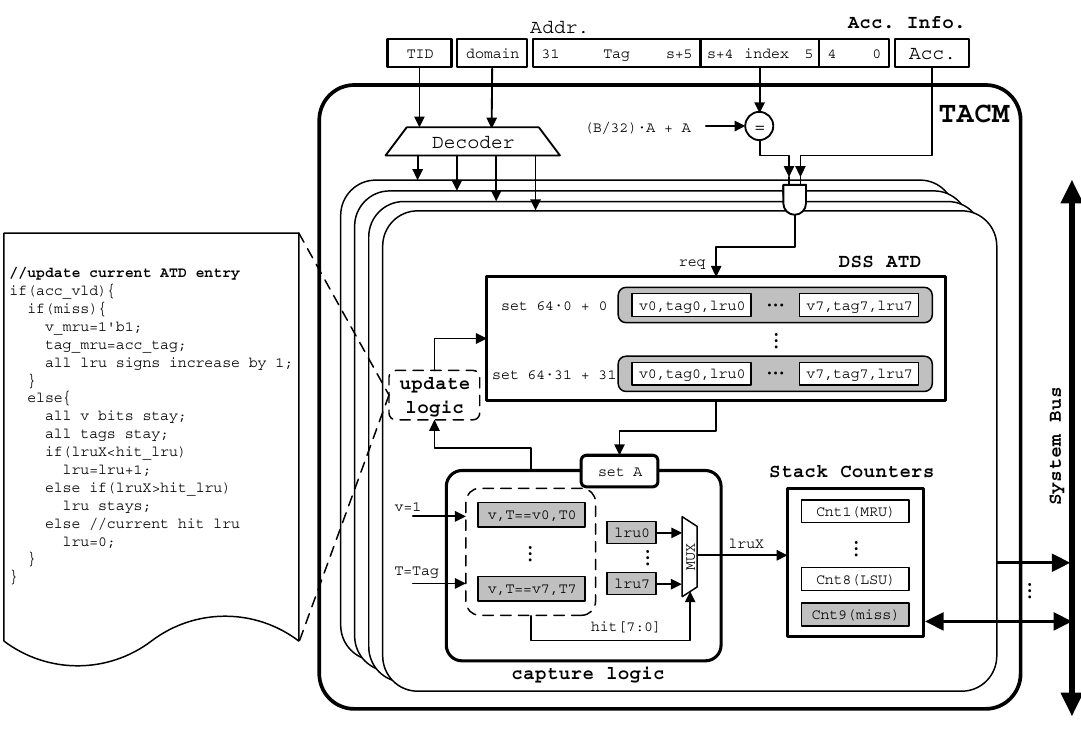
Figure 7. An example of TACM architecture.